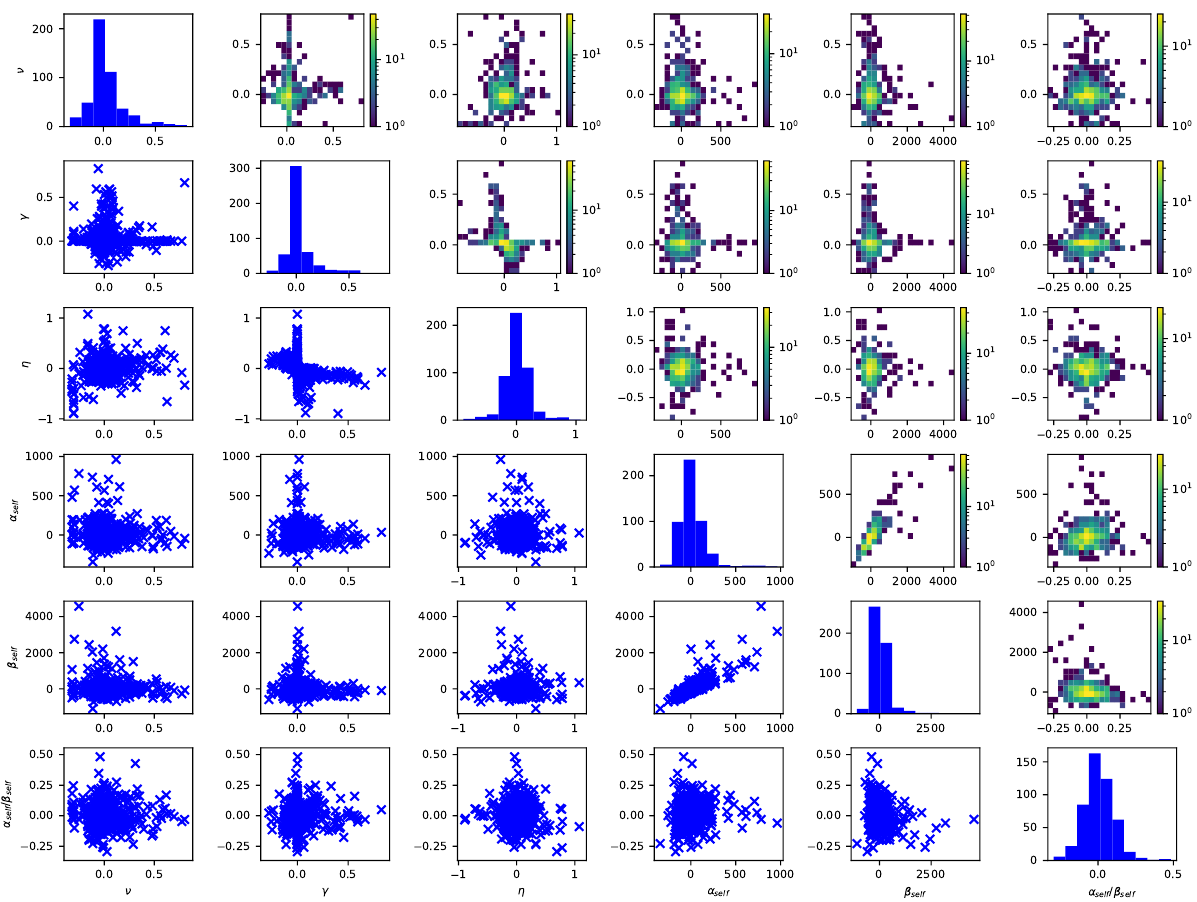
Figure 6. Histograms ( diagonal ), scatter plots ( lower triangle ) and two-dimensional histograms ( upper triangle ) of the parameters of the model with